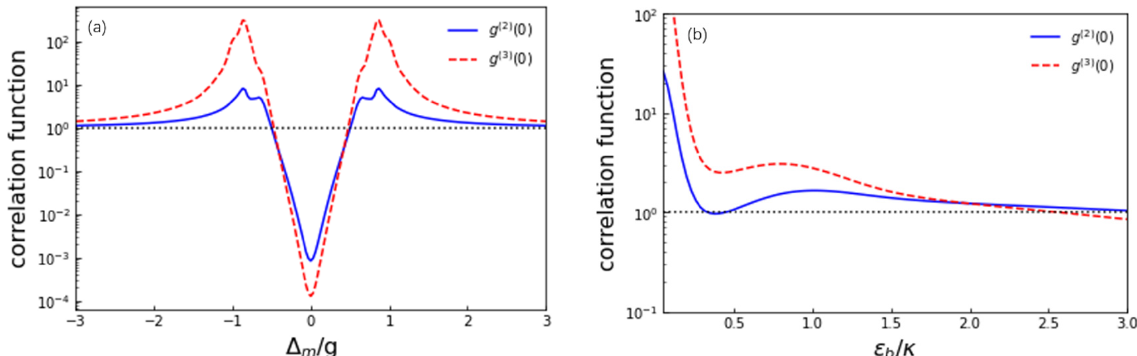
Figure 2. Steady-state equal-time ( a ) second-order correlation function 𝑔 ((cid:2870)) (0) and ( b ) third-order correlation function 𝑔 ((cid:2871)) (0) versus the detuning Δ (cid:3040) /𝜅 and the coupling strength 𝑔/𝜅 when the mechanical resonator is weakly driven. The system parameters we take are 𝛾 = 0.01𝜅 , ε (cid:3029) = 0.15𝜅 and 𝑛 (cid:2930)(cid:2918) = 0 . The white dashed curve in ( a ) corresponds to the case of two-phonon resonant driving, √(cid:2870) 𝑔 . i.e., Δ (cid:3040) = (cid:3399) (cid:2870)